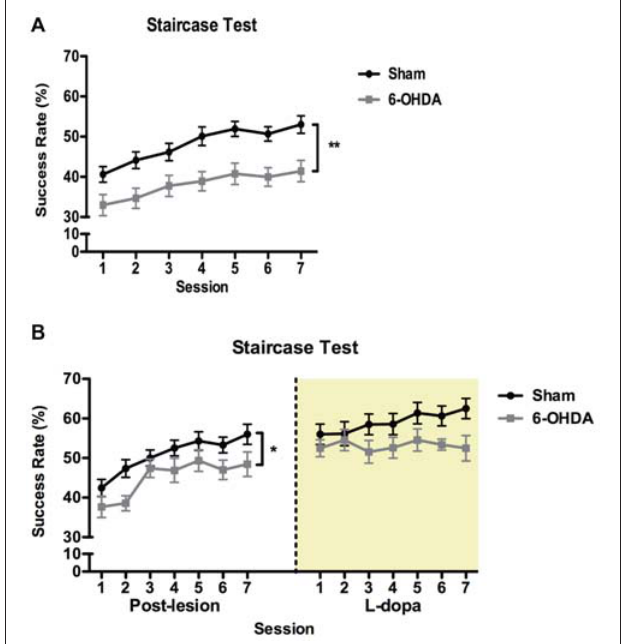
FIGURE 3 | Effect of 6-OHDA lesions and levodopa (LD) treatment on skilled forelimb motor function. (A) Longitudinal post-lesion assessment of